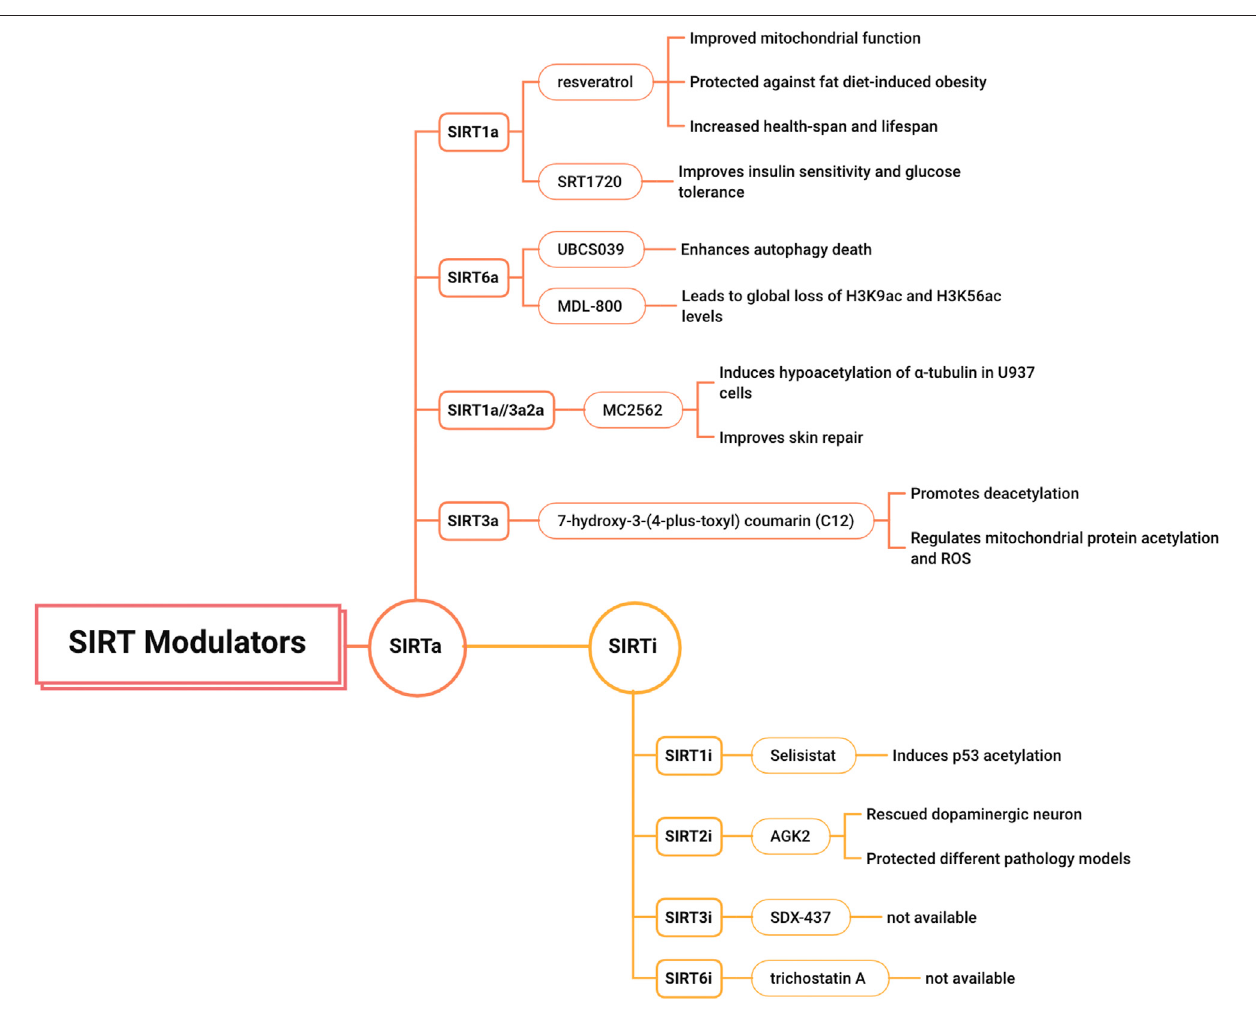
FIGURE 5 | The modulators of